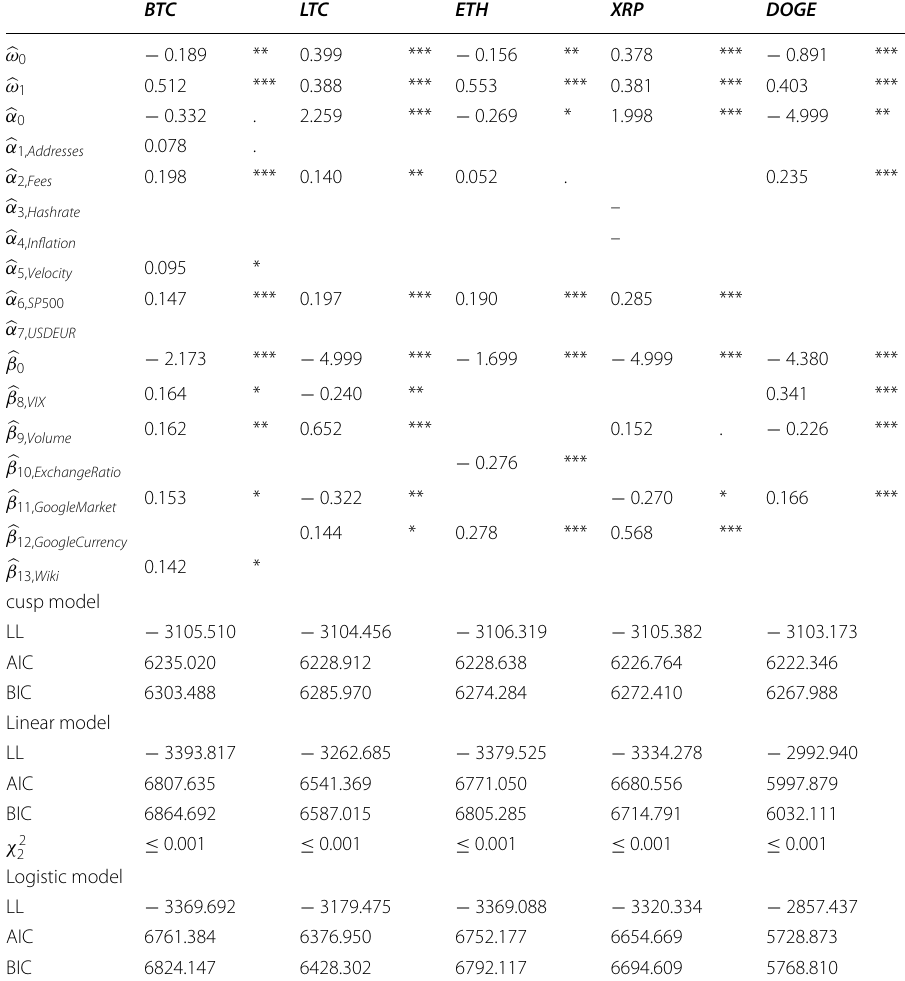
Table 1 Estimation